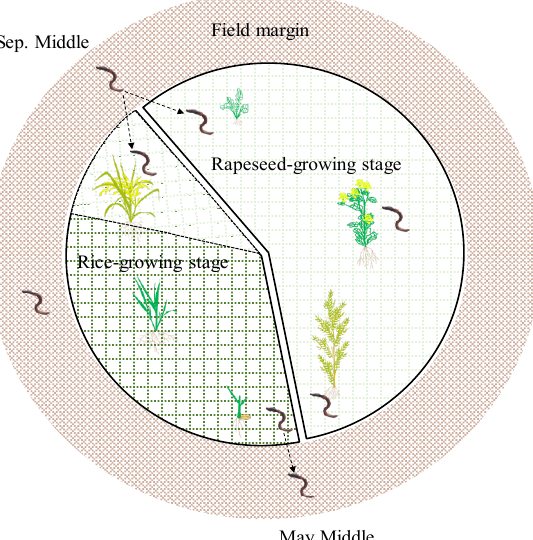
Figure 2. The schematic diagram of earthworm migration between field margins (FM) and arable field (AF) during the growth stage of rice and rape. Dotted arrow represented the movement of earthworms between FM and AF.